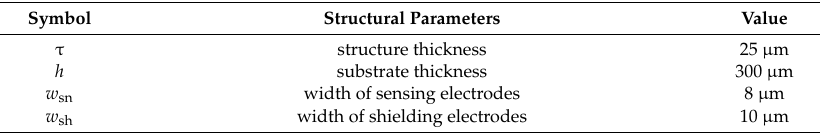
Table 1. The key parameters of the proposed 1D